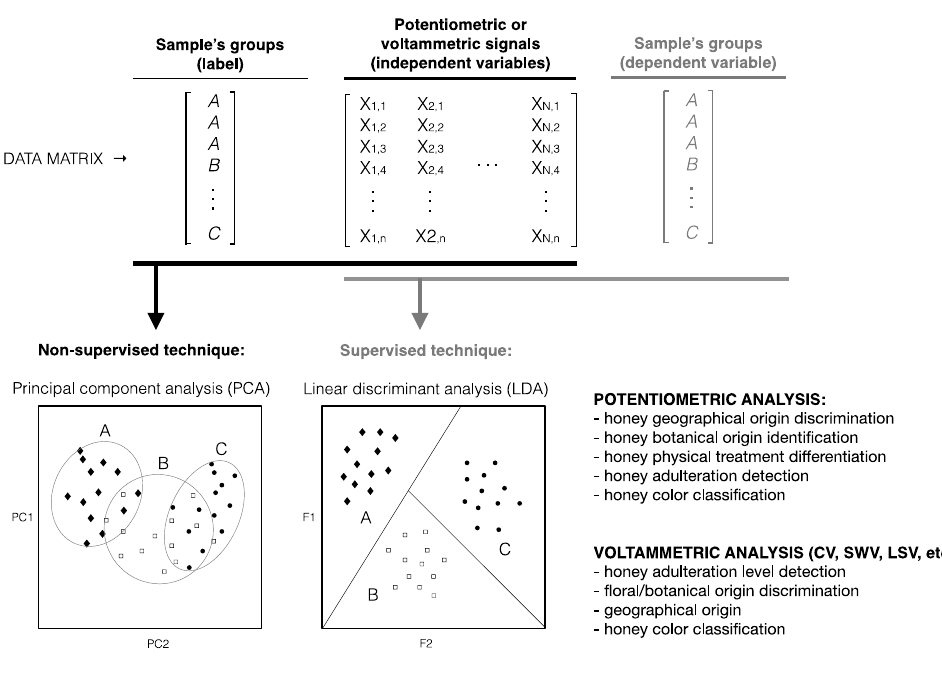
Figure 3. Common qualitative applications of potentiometric and voltammetric E-tongues coupled with chemometric tools for honey analysis, according to the literature survey.